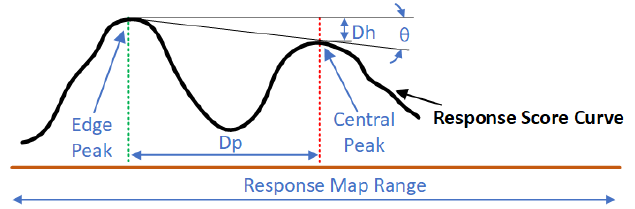
Figure 6. Object centre switching